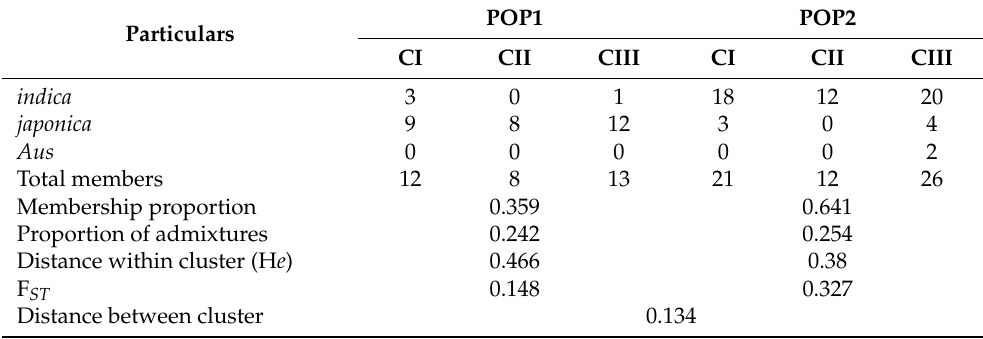
Table 5. Subpopulation genetic parameters and distribution of various classes of WCVs and agro- nomic clusters among the subpopulations .